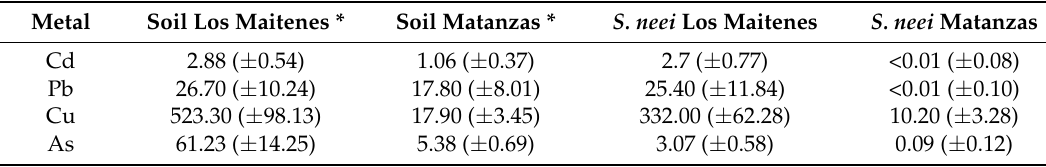
Table 1. Concentration of heavy metals in the soil and plants (mg kg − 1 ± SE).